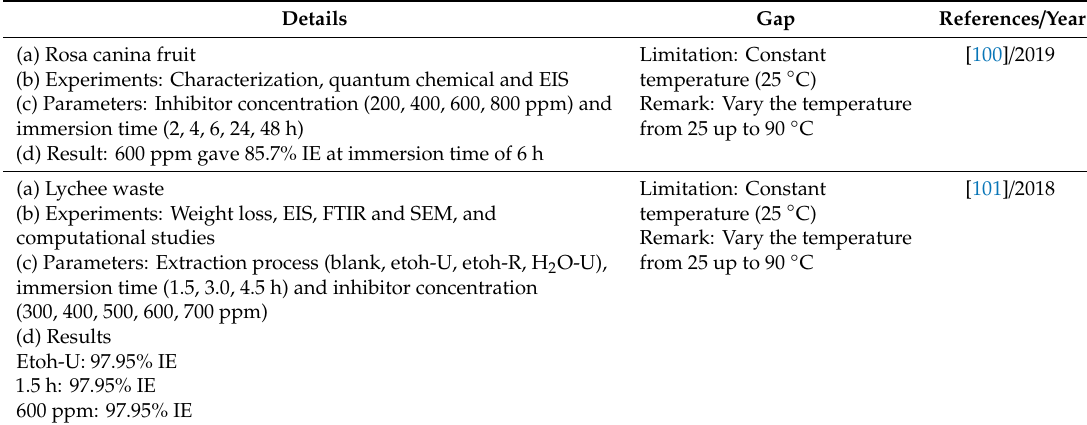
Table 2. Summary of research gap for fruit-based green corrosion inhibitors from 2010 to